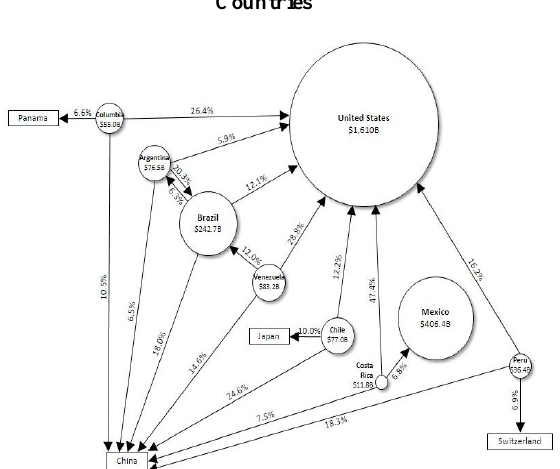
Figure 4. Largest Import Partners for NAFTA Countries